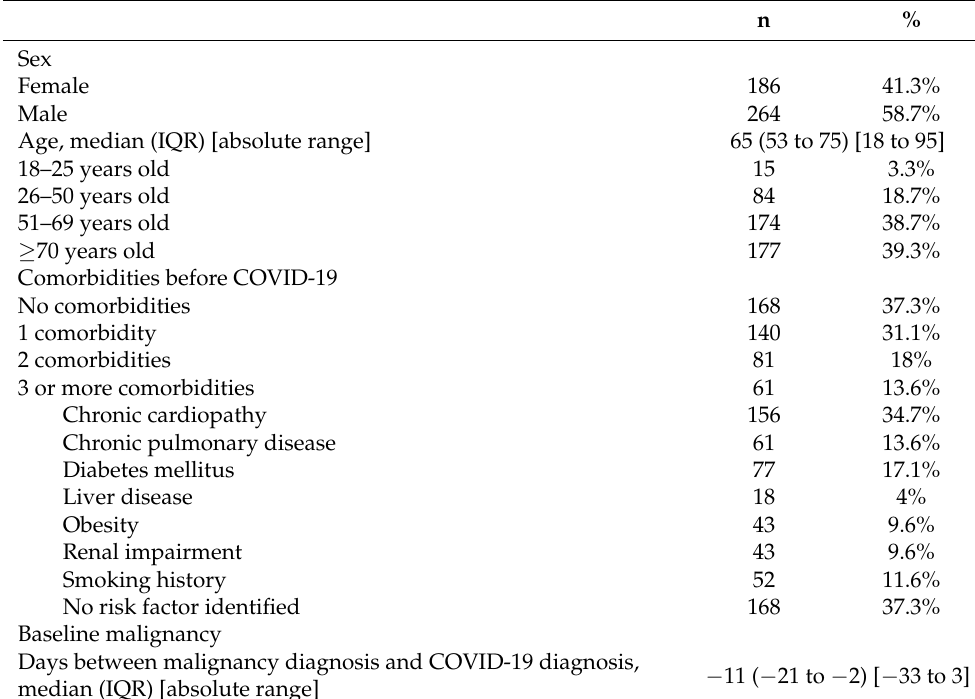
Table 1. Characteristics of patients with simultaneous onset of haematological malignancy and